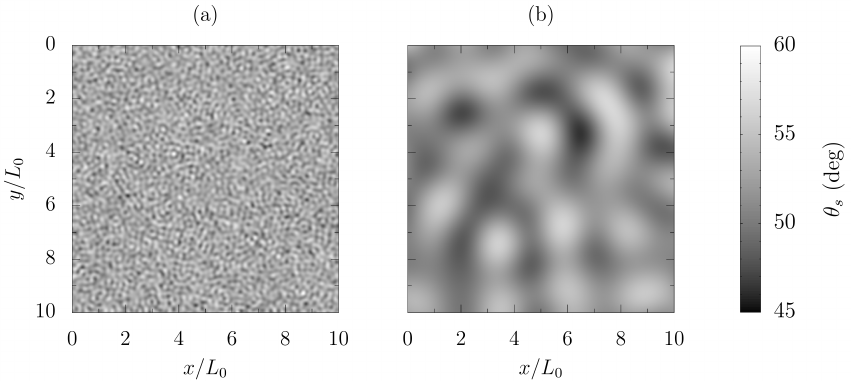
Figure 11. Zoom of the static contact angle distribution over the randomly generated heterogeneous